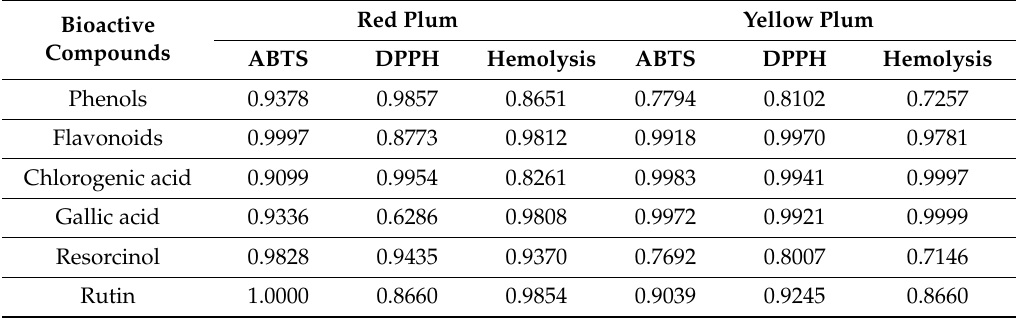
Table 4. Correlation between antioxidant capacity by the ABTS, DPPH and hemolysis methods with phenols, flavonoids and compounds quantified by UPLC-MS in ethanolic